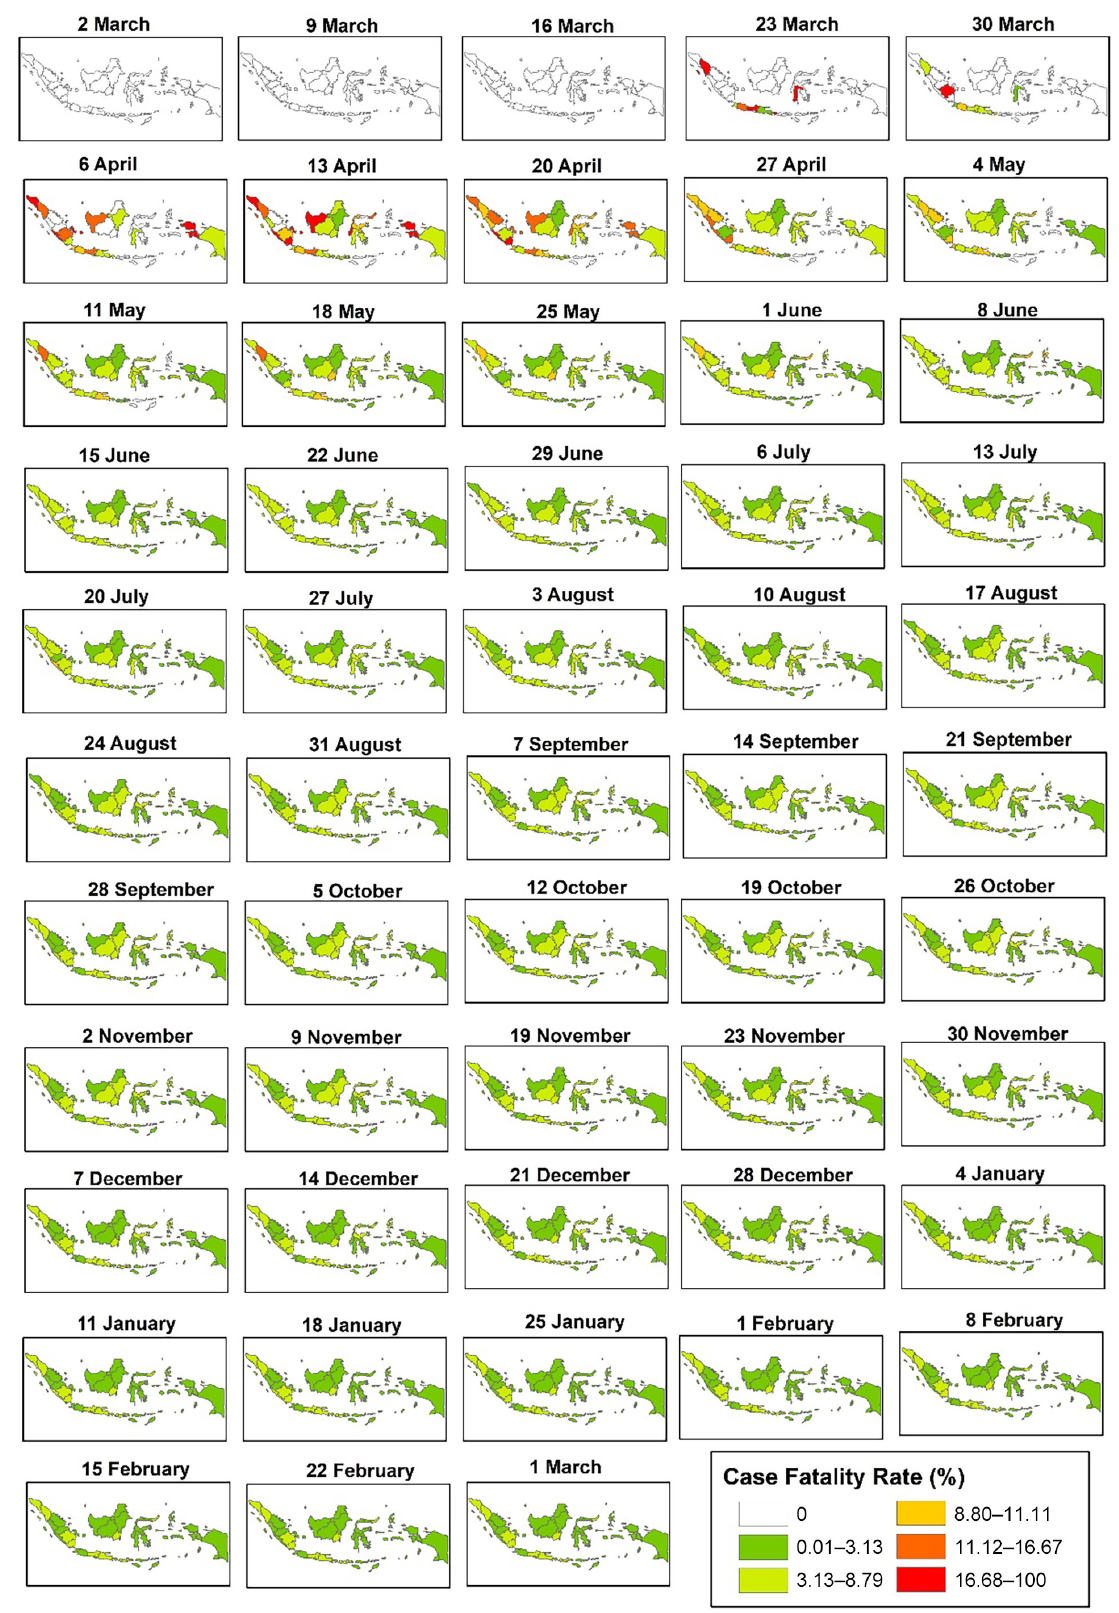
Fig. 5. CFR of COVID-19 between March 2020 and March 2021. CFR – case fatality rate. Source: own